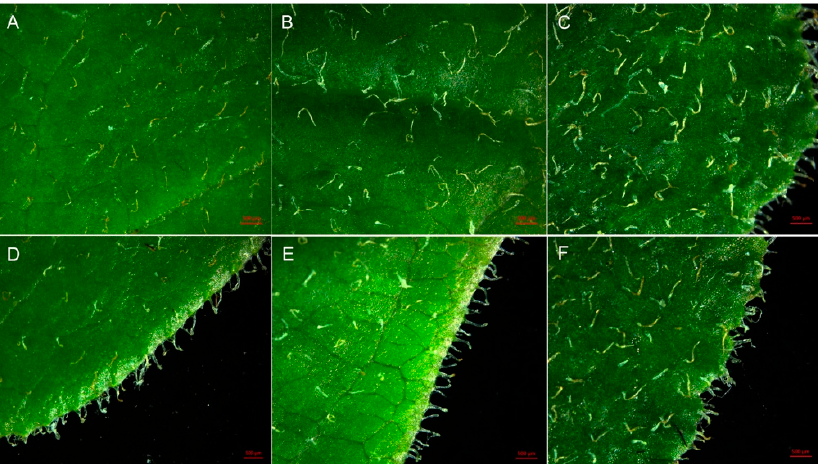
Figure 4. Leaf epidermal hairs of polyploid and diploid plants. A and D , epidermal hairs in the center ( A ) and on the edge ( D ) of a diploid leaf; B and E , epidermal hairs in the center ( B ) and on the edge ( E ) of a tetraploid leaf; C and F , epidermal hairs in the center ( C ) and on the edge ( F ) of an octoploid leaf. Scale bar = 500 μ m.